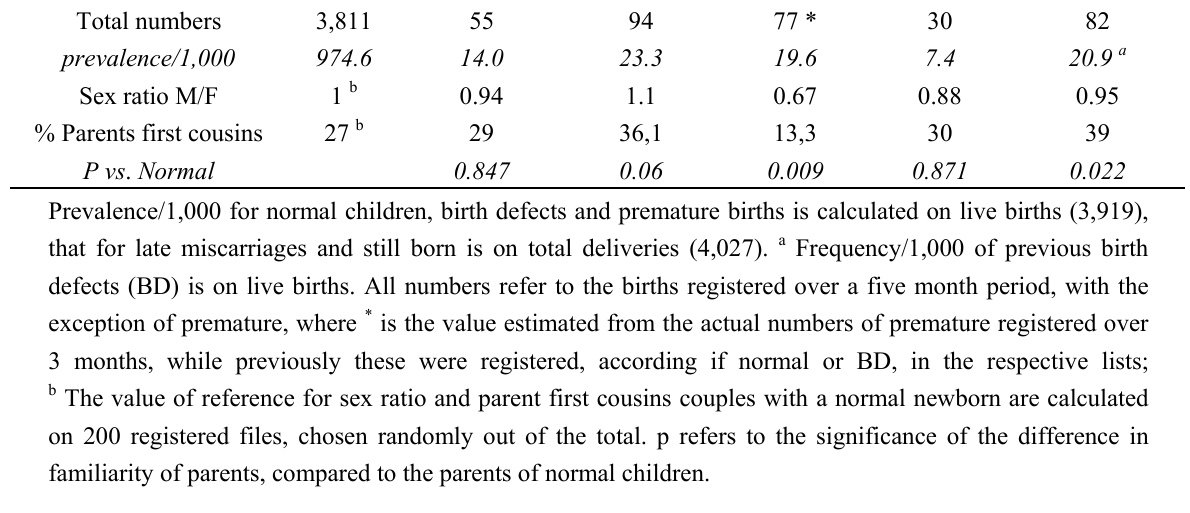
Table 2. Prevalence of reproductive problems, sex ratio of newborns and parent’s intermarriage. New born